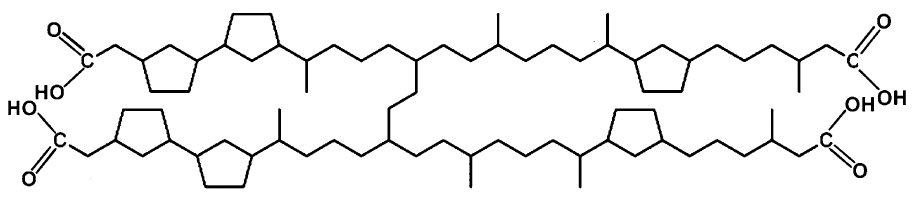
Fig. 1 Chemical structure of C 80 tetraacid (ARN) (Lutnaes et al.